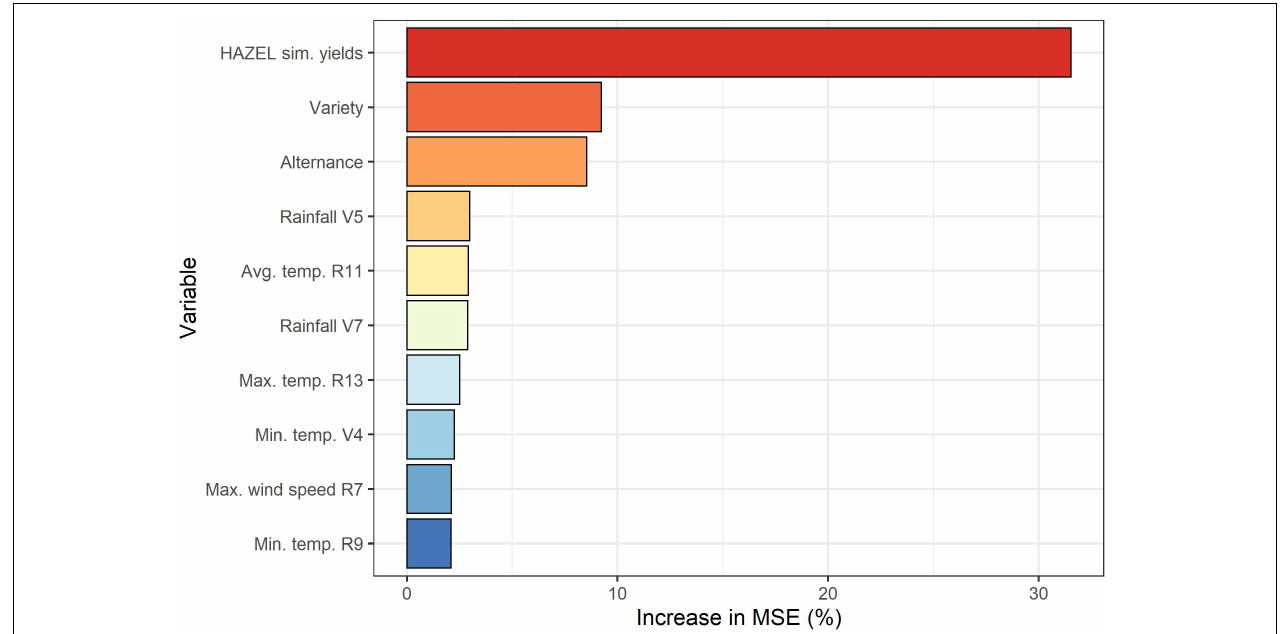
FIGURE 5 | Median variable importance calculated over all 100 model iterations in terms of mean percentage increase in Mean Square Error (MSE,